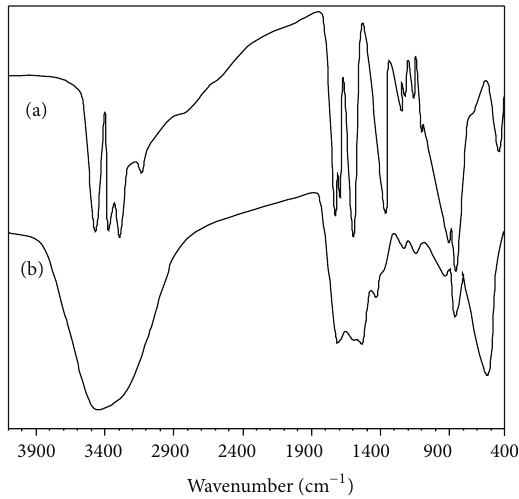
Figure 12: The infrared spectrum of o-phenylenediamine (OPDA) (a) and it analogous polymer (POPDA) (b).